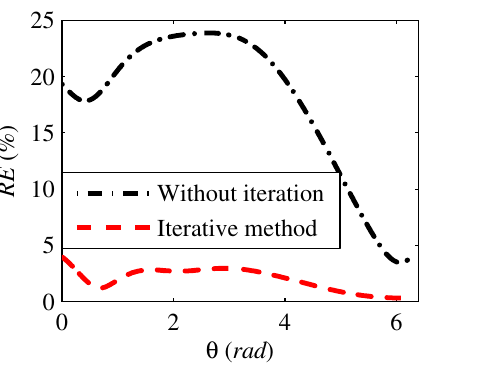
Figure 4. The RE versus